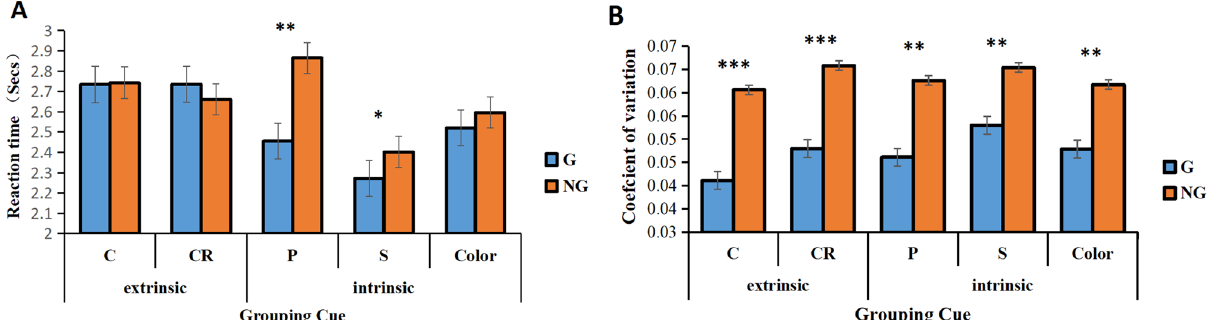
Figure 3. Grouping cue effect. RTs ( A ) and CV ( B ) for different grouping cues by group condition (G for grouping condition, NG for no-grouping condition; C for connectedness, CR for common region, P for proximity, S for shape, Color for color). *** p < 0.001; ** p < 0.01; * p <